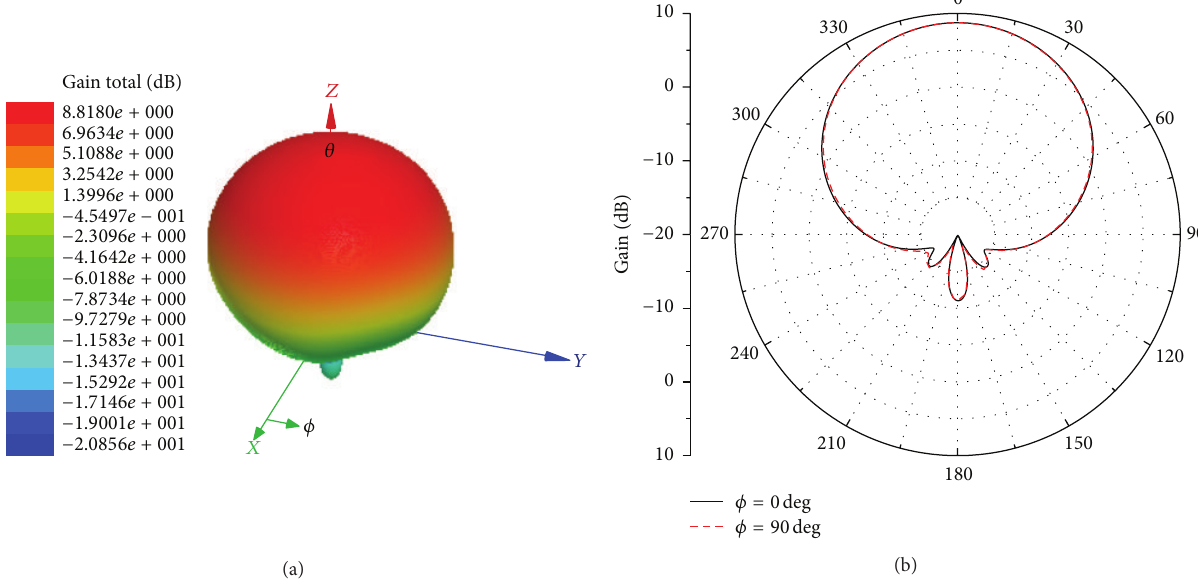
Figure 11: Radiation patterns of the proposed antenna with right-hand circular polarization. (a) 3D polar plot. (b) Polar plot.